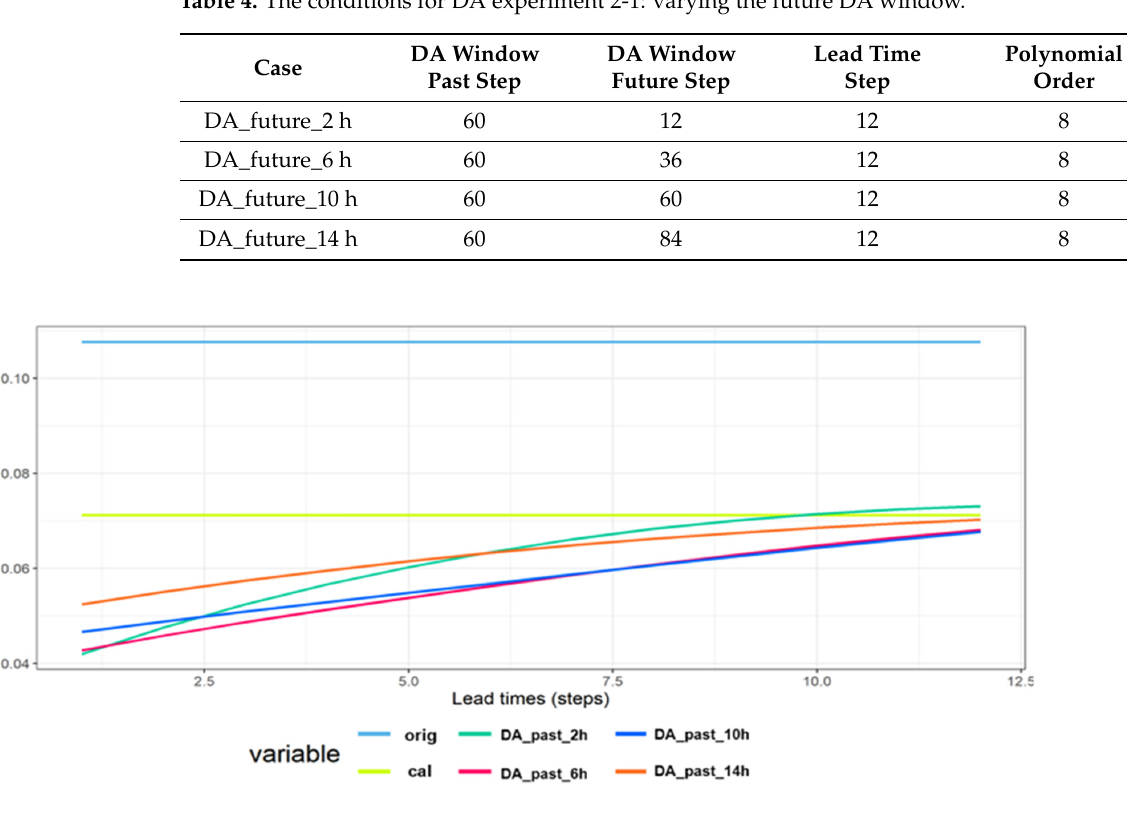
Figure 9. Performance of tidal wave prediction with varying past DA window sizes.